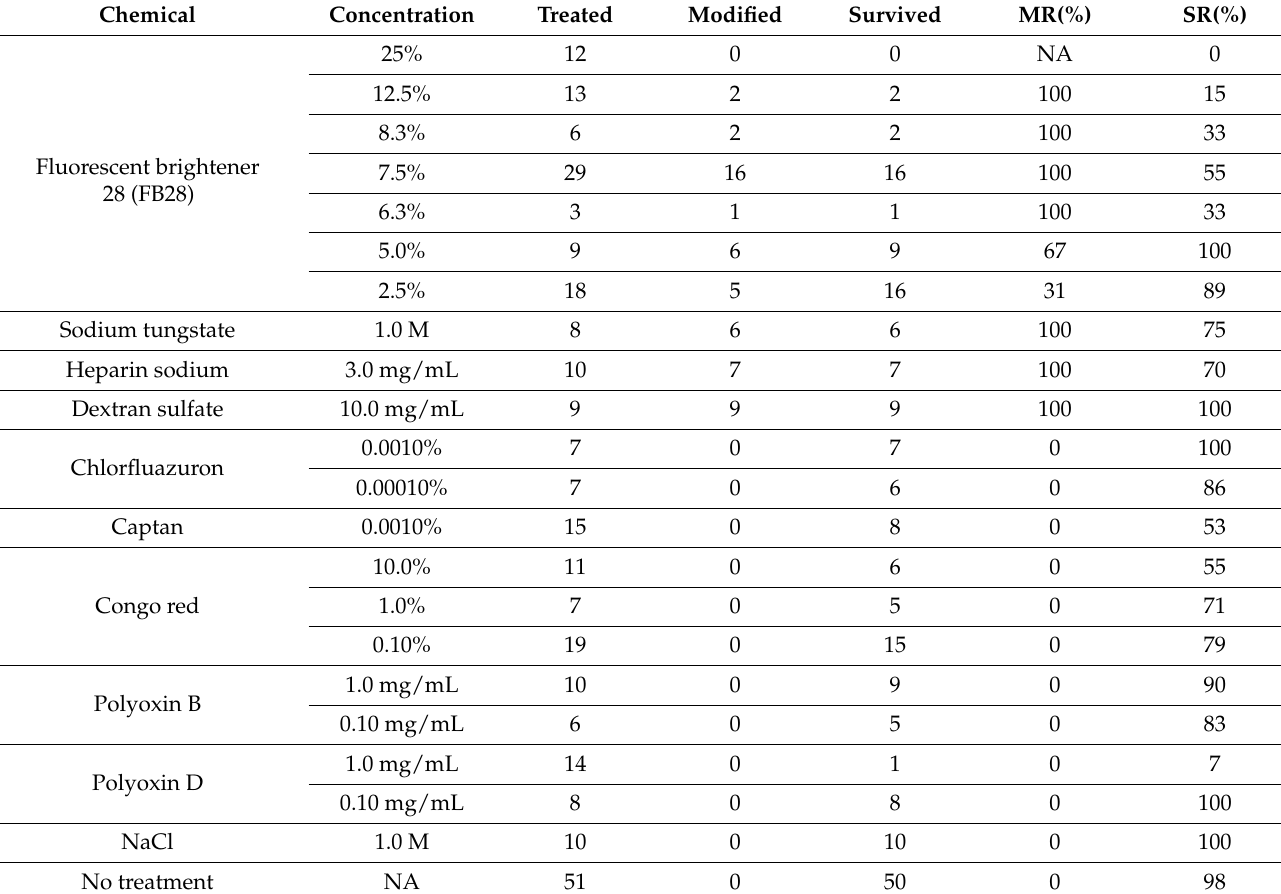
Table 1. Number of individuals with wing color pattern modifications induced by chemical